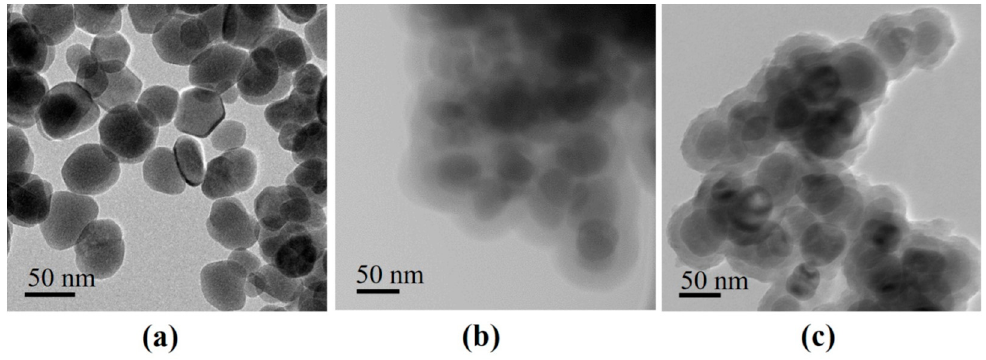
Figure 2. TEM images of neat and surface modified nanoparticles: ( a ) Fe 3 O 4 ; ( b ) Fe 3 O 4 @SiO 2 /SiTMC and ( c ) Fe 3 O 4 @SiO 2 /SiCHIT.